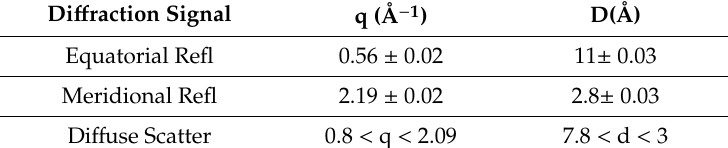
Table 3. Equatorial, meridional, and diffuse reflections of the native soluble collagen.